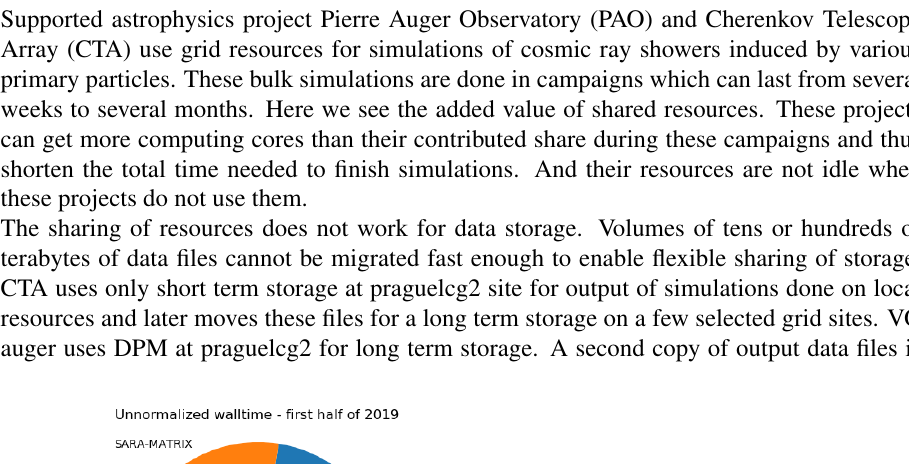
Figure 6. VO auger uses several sites connected to the EGI grid infrastructure for bulk simulations of cosmic ray showers. Usage of praguelcg2 resources by local user jobs is not included in this